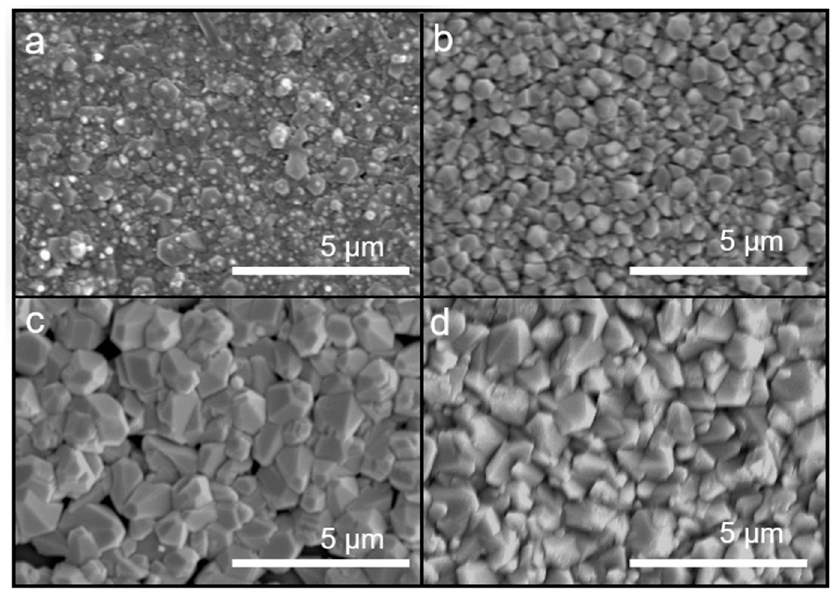
Figure 3. SEM images of ZnO coatings prepared using the atmospheric microplasma-assisted ultrasonic spray pyrolysis process at ( a ) 400 °C, ( b ) 350 °C, ( c ) 400 °C with vacuum annealing, and ( d ) 350 °C with vacuum annealing.